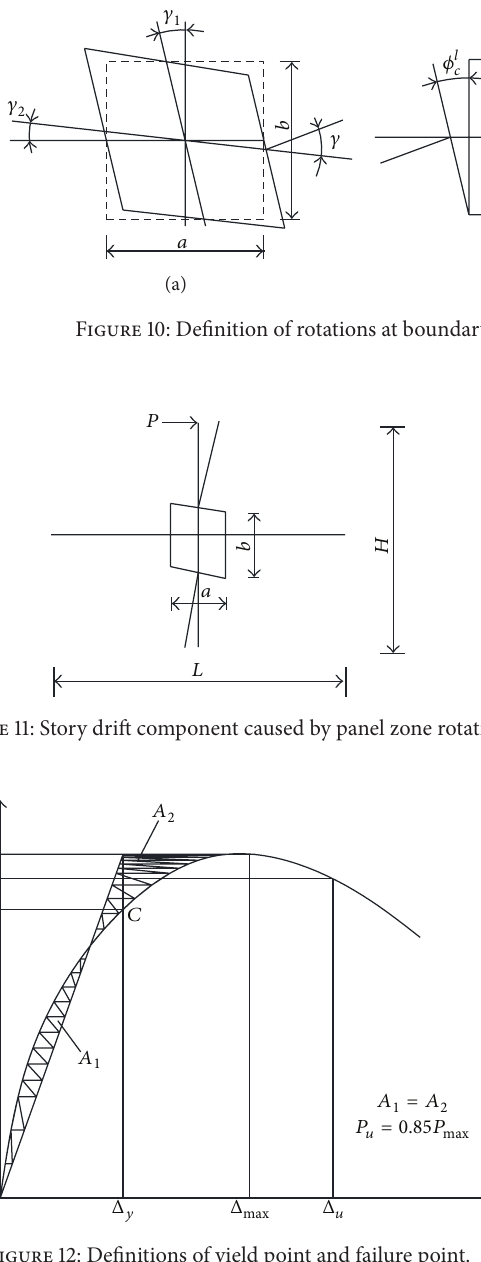
Figure 12: Definitions of yield point and failure